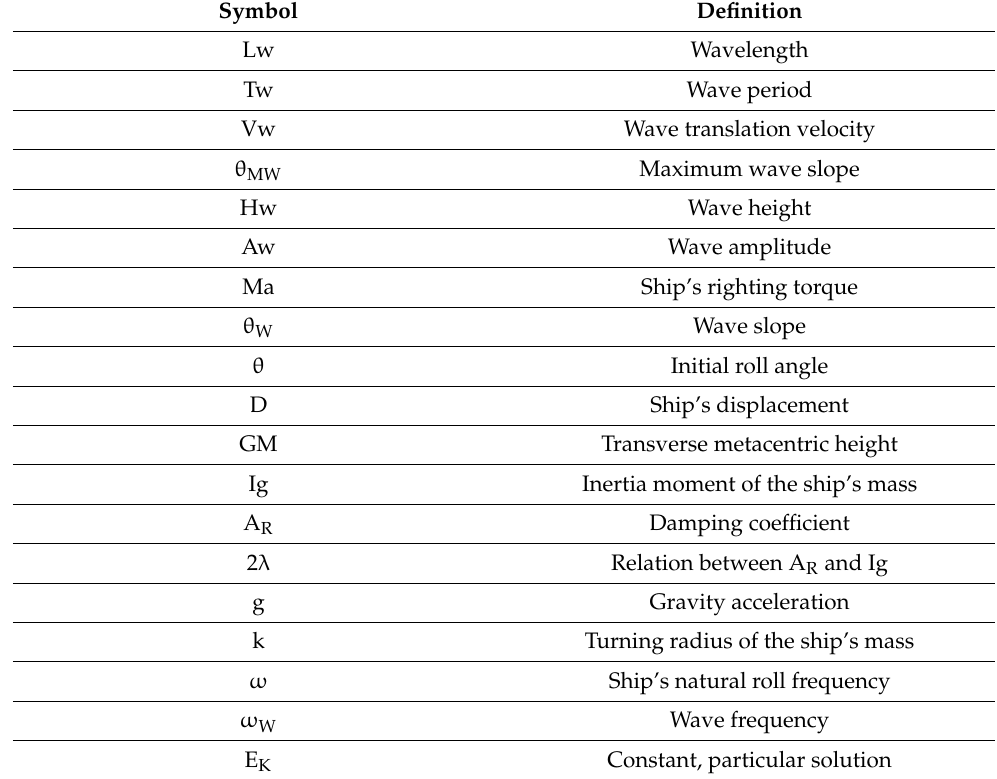
Table A1. Symbols and Its